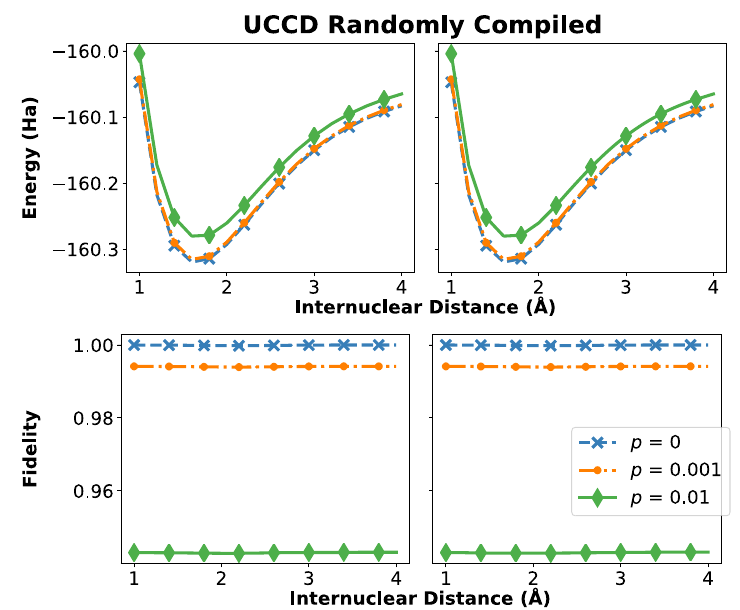
obvious differences between the selected θ for the ground state as the depolarizing noise increases for both optimizers. For example, the COBYLA optimizer has a greater vari- ance than that of the L-BFGS optimizer, especially at higher values of R . When comparing the differences in optimal parameter selection between optimizers at the same level of noise, we report no significant difference to the resultant energy or fidelity between the respective optimizers. Fig. 6. The general trend of increasing energy and decreasing fidelity as the depolarizing noise increases is still seen within this plot. The general shape of the energy curve is standard to that of potential energy curves, and the fidelities are relatively flat across all R .